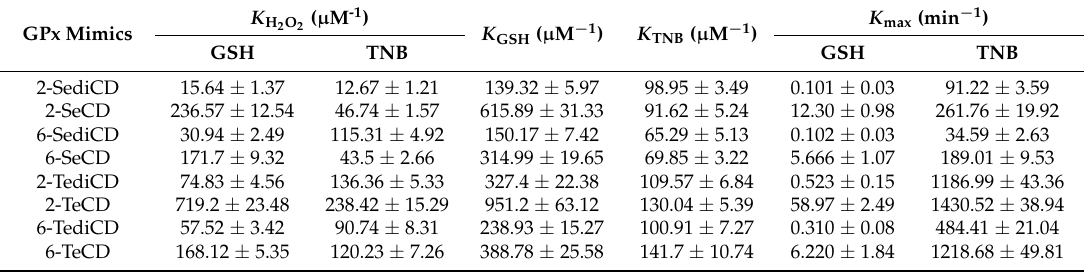
Table 3. Kinetic parameters for the mimics-catalyzed reduction of hydroperoxides by GSH and TNB. GPx